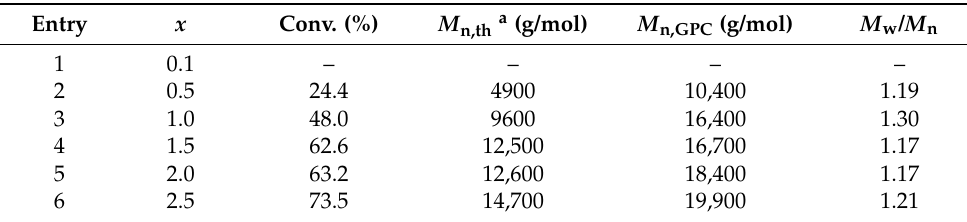
Table 4. Effect of the concentration of 1,1 1 -azobis (cyclohexanecarbonitrile) (ACHN) on ICAR ATRP of